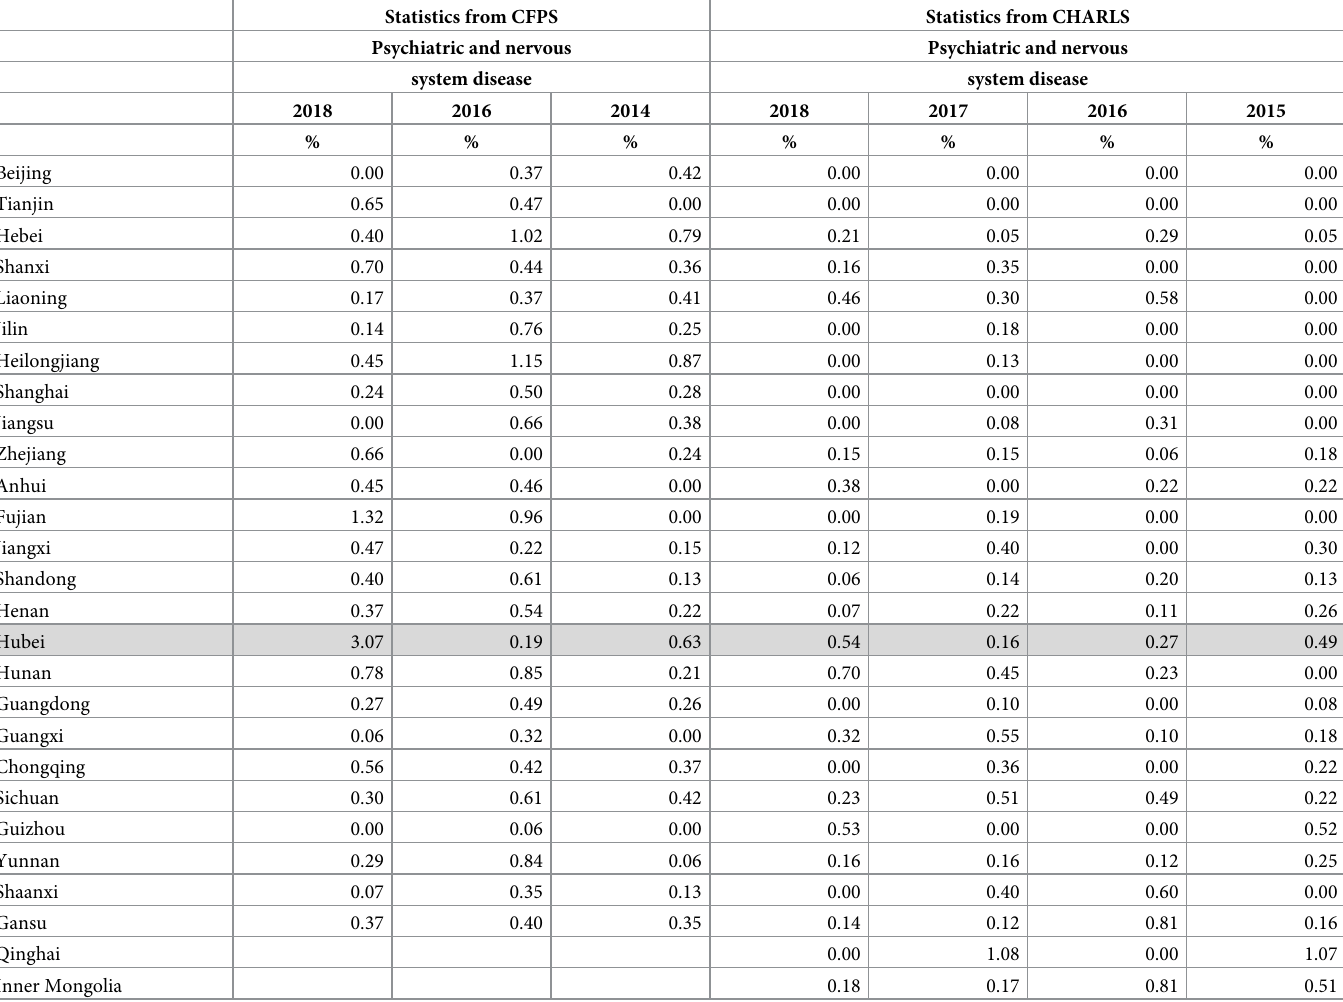
Table 6. Diagnosis of psychiatric and nervous system disease by province and